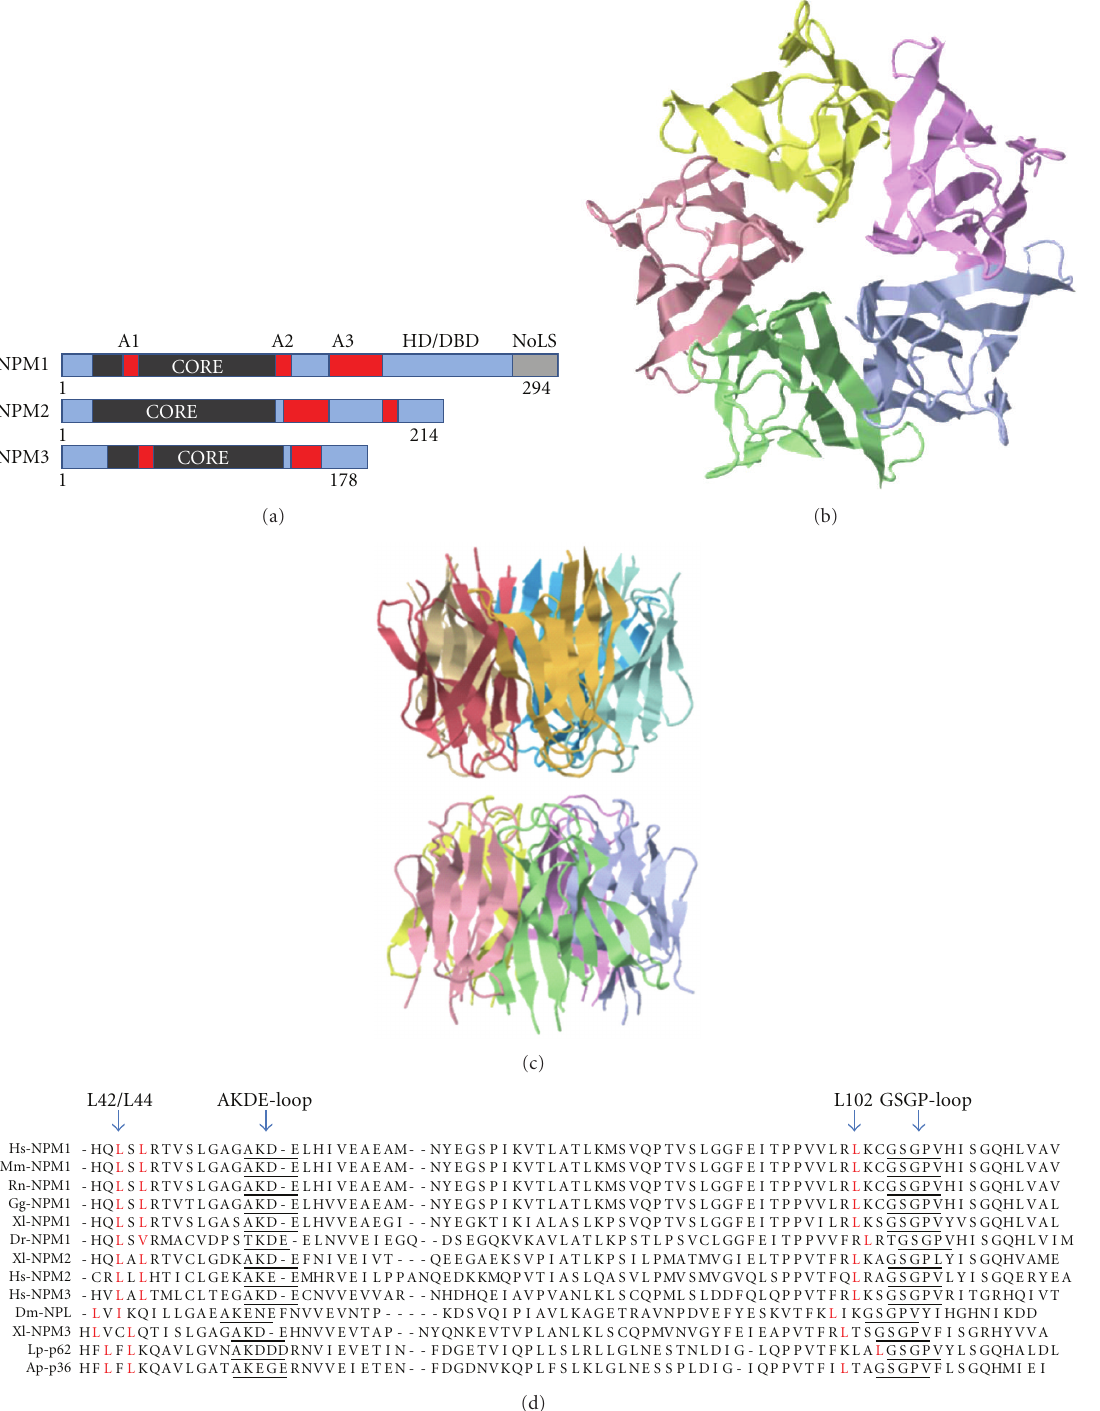
Figure 1: Structure of NPM1. (a) Domain representation of human NPM1, NPM2 and NPM3 proteins. Acidic patches (“A”) are indicated. (HD: heterodimerization domain, DBD: DNA binding domain, NoLS: nucleolar localization motif). (b) Pentamer structure of Xenopus laevis xNPM1/NO38 (PDB ID: 1XE0) as visualized in Jalview PDB viewer. (c) Two pentamers of human NPM1 (PDB ID: 2P1B) stacked in a decameric configuration. (d) Sequence alignment of the core region from di ff erent NPM1 proteins and NPM-like proteins. Clustal W was used for alignment and further editing was done with help of Chromas alignment software. The structurally important “AKDE” and “GSGP” loops are indicated in the figure as well as the location of conserved L42 and L102 residues (reference to human NPM1). Hs: Homo sapiens; Mm: Mus musculus; Rn: Rattus norvegicus; Dr: Danio rerio; Gg: Gallus gallus; Xl: Xenopus laevis; Dm: Drosophila melanogaster; Lp: Lytechinus pictus (sea urchin); Ap: Asterina pectinifera (star